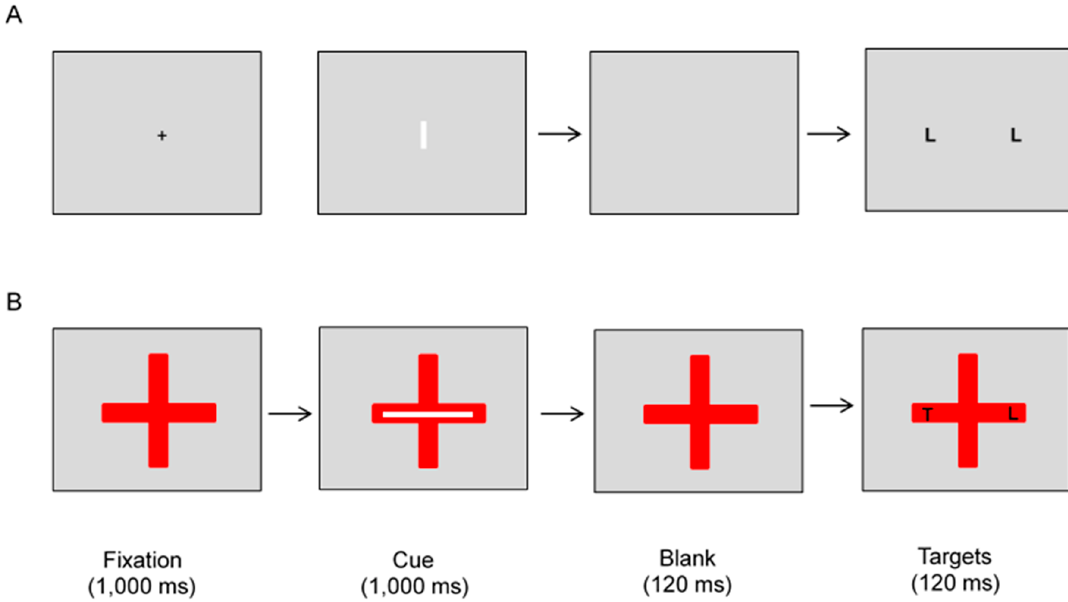
Figure 1. Examples of trials from Experiment 1. On each trial, participants saw a long or a short bar oriented horizontally or vertically, and this was followed by two target letters that were either horizontally or vertically aligned. The validity of the cue was 75%. For one group of participants (the object-present group), all the stimuli were shown on a red cross. For the other group of participants (the object-absent group), the stimuli were presented directly against a grey background. For all participants, the task was to judge whether the two target letters were the same or di ff erent. ( A ) An example of an object-absent, incongruent trial with a short cue. ( B ) An example of an object-present, congruent trial with a long cue. Note that the figure is not drawn to